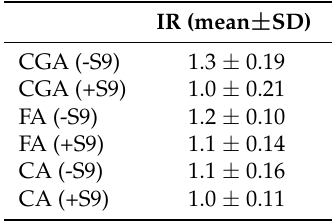
Table 3. Evaluation of genotoxic activity of the phenolic acids based on IR values of the highest tested concentration (10 µ